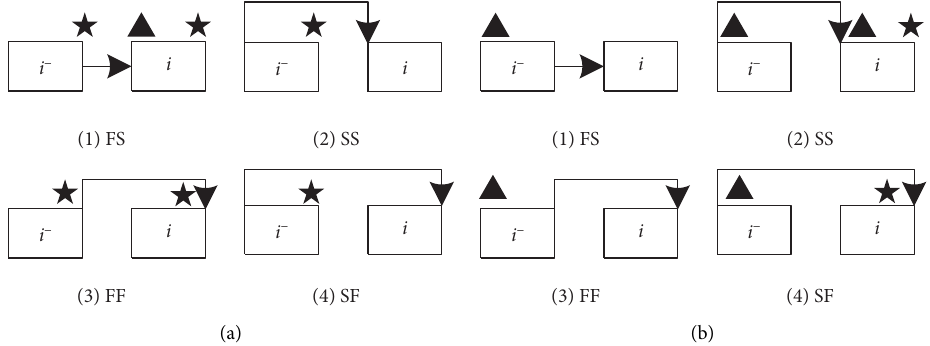
Figure 3: Infection of schedule change risk. ★ represents an end date change risk, and ▲ represents a start date change risk. Node i − is the predecessor of node i . Risk propagation caused by (a) the end date change and (b) start date